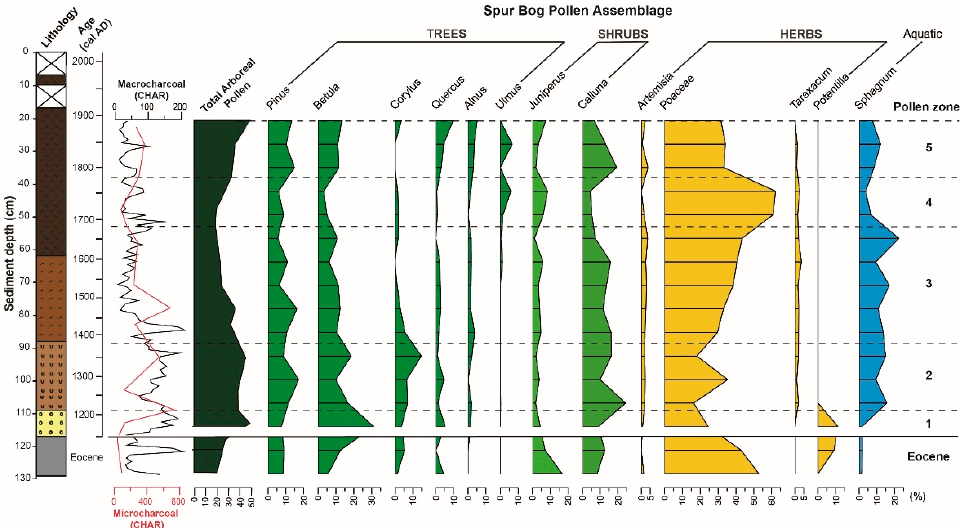
Figure 8. Pollen percentages of selected arboreal, shrub, herbaceous and aquatic pollen types in Spur Bog compared to lithology, total AP and macro- and microcharcoal fragment counts. See Figure 7 for the key of the lithological log.